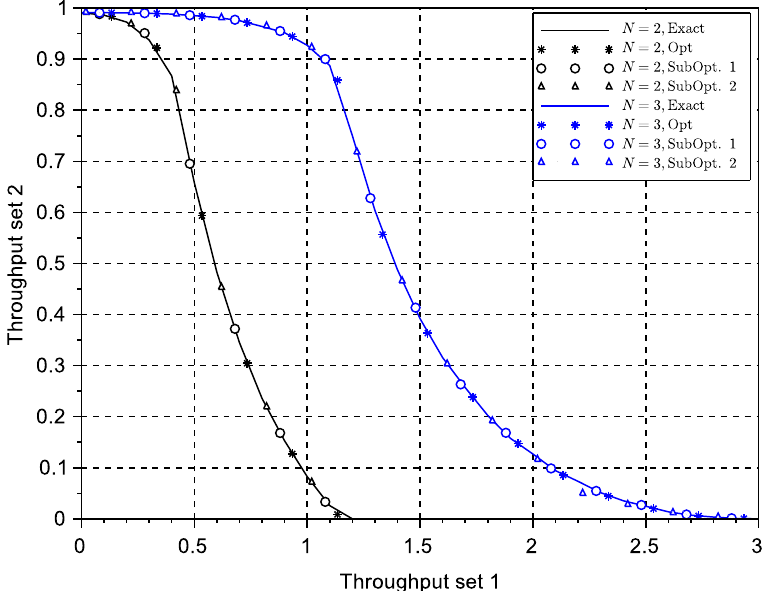
Figure 3. Throughput region of a multi-packet reception (MPR) system with two subsets of terminals: J 1 = 3 and J 2 = 1 using the N -reception model with different values of N .